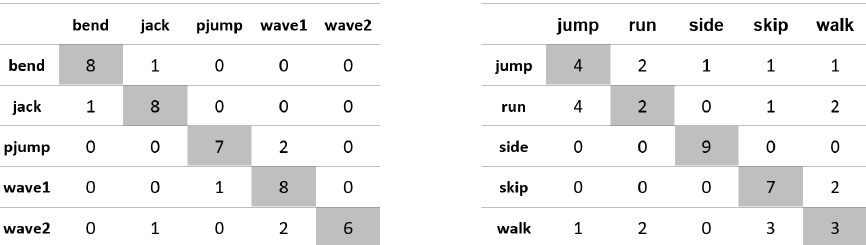
Figure A3. Confusion matrices for the experiment using the ‘lower-occlusion’ database, eccentricity and Euclidean distance.